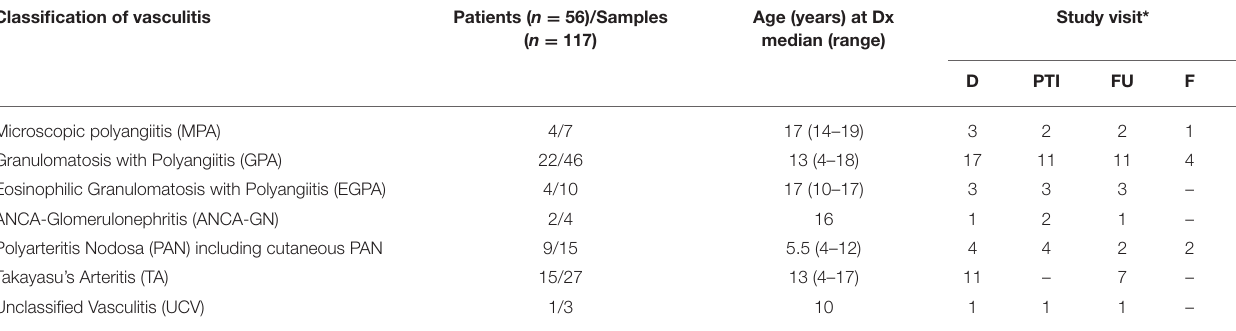
TABLE 1 | Study samples. Classification of vasculitis Patients ( n = 56)/Samples